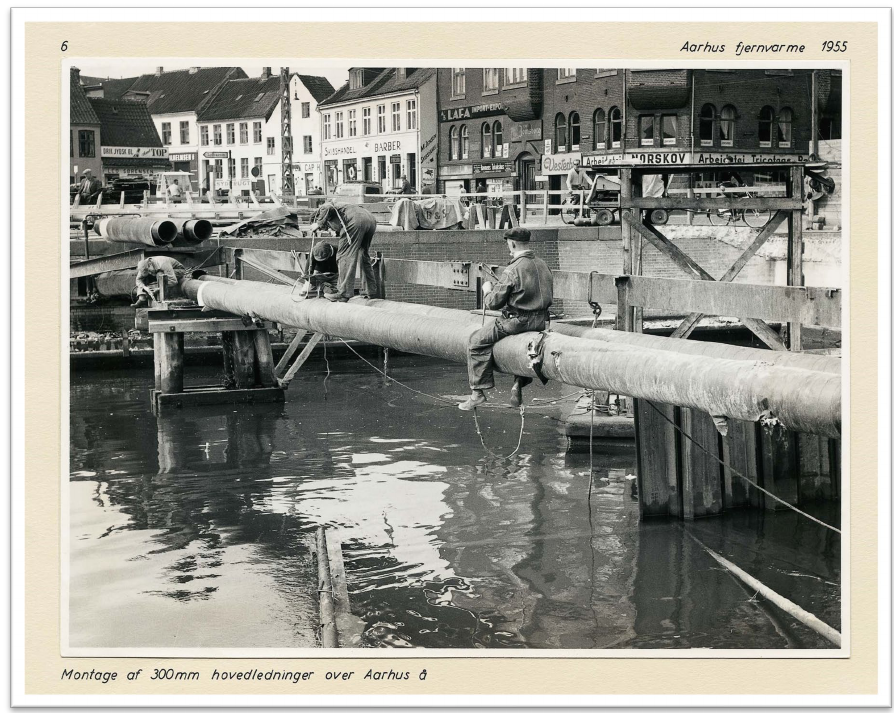
Figure 4. Deployment of 300 mm main pipes across the water in Aarhus, 1955. Source: Affaldvarme Aarhus; this was printed with permission.